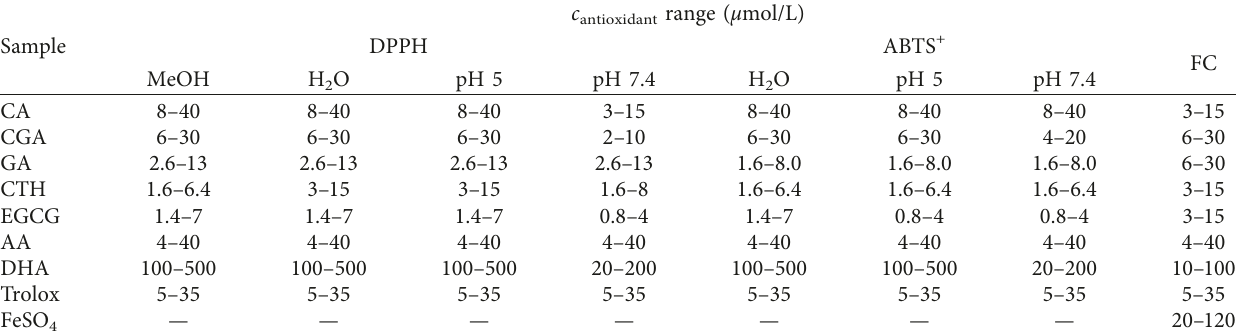
Table 1: The range of concentration of antioxidants in assay solution ( c